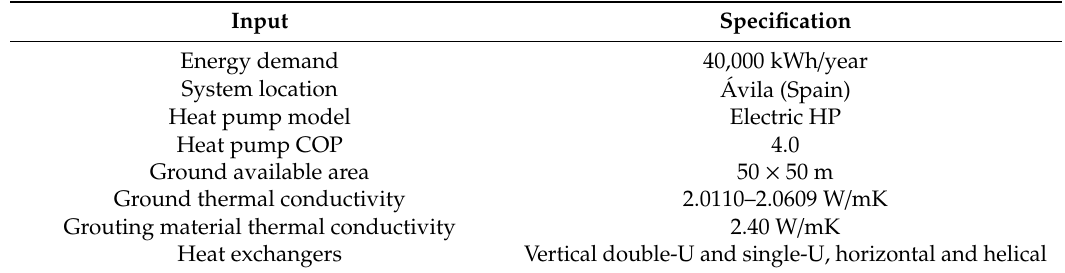
Table 4. Input data of the geothermal systems to be introduced in GES-CAL software.